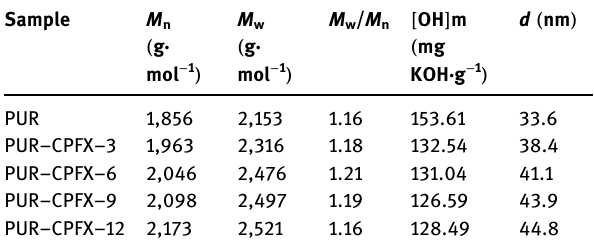
Table 2: GPC data, hydroxyl value as well as particle size of PUR and